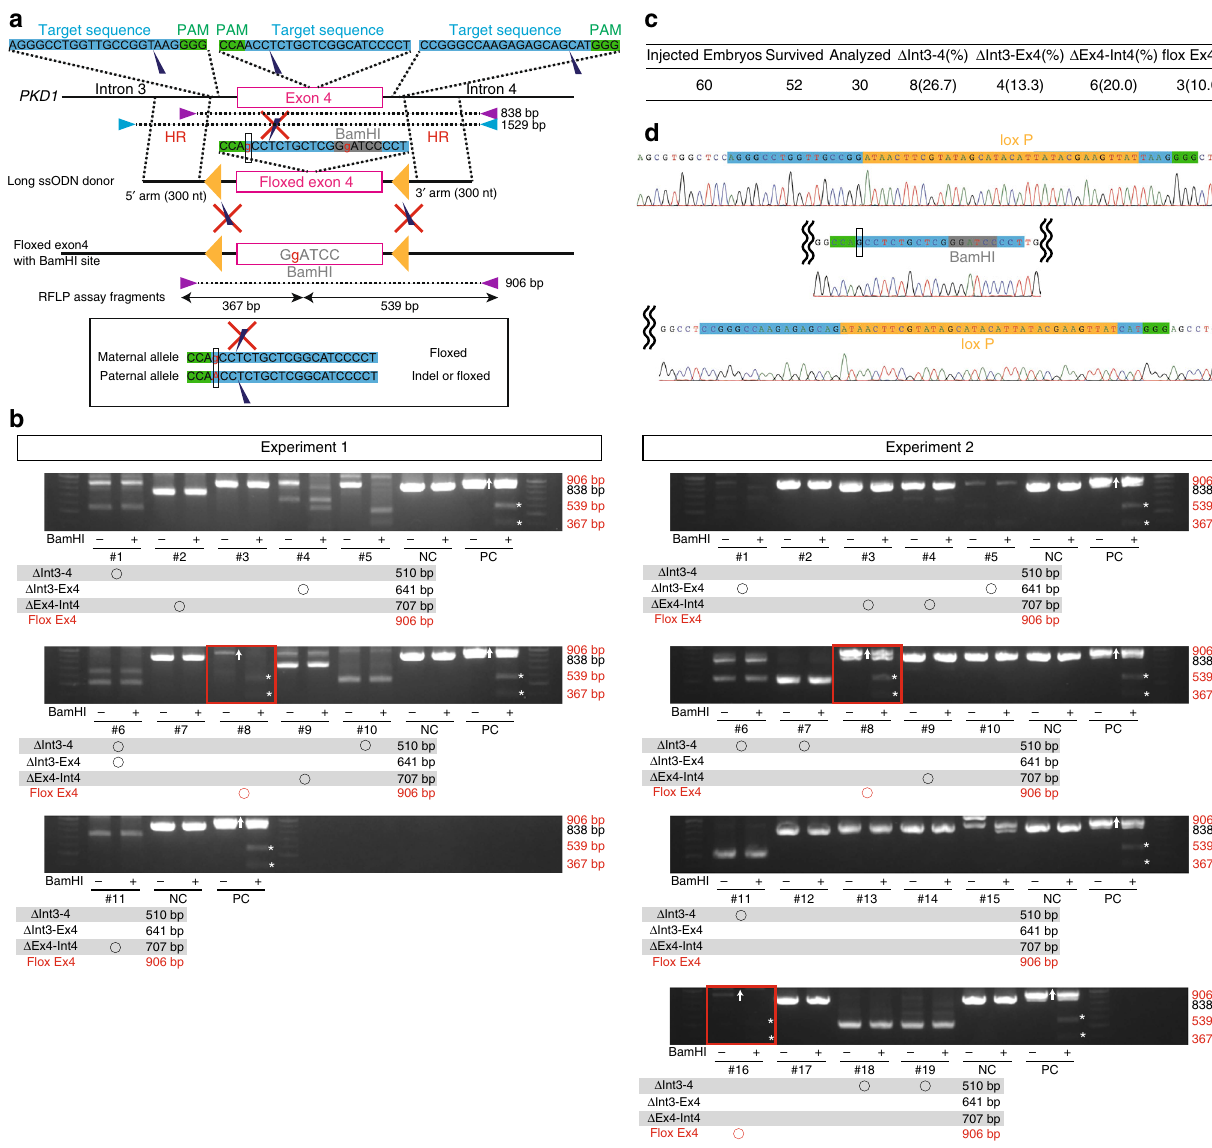
Fig. 8 Generation of a fl oxed allele in monkey embryos. a Schematic diagram showing the fl oxed allele knock-in strategy. Purple triangles indicate PCR primers for RFLP assay. Blue triangles indicate PCR primers for sequencing. Yellow triangles indicate loxP sequences. b RFLP assay using Bam HI for detection of the fl oxed allele. Asterisks indicate positive bands. “ NC ” indicates negative control, in which wild-type DNAs were used as PCR templates. “ PC ” indicates positive control, in which knock-in DNAs were used as PCR templates. n = 30 biologically independent samples. c Ef fi ciencies of deletion and fl oxed allele knock-in. d The inserted sequence in the fl oxed allele. Source data are provided as a Source Data fi